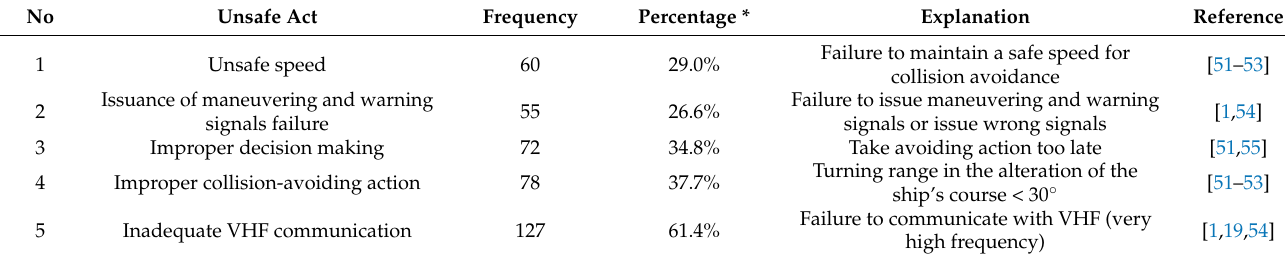
Table 2. Critical unsafe acts of seafarers in the 207 collision